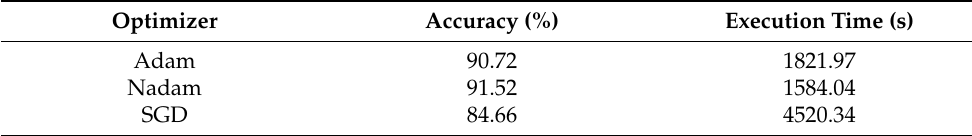
Table 4. The experimental results of different optimizers (GRU = 256, learning rate =